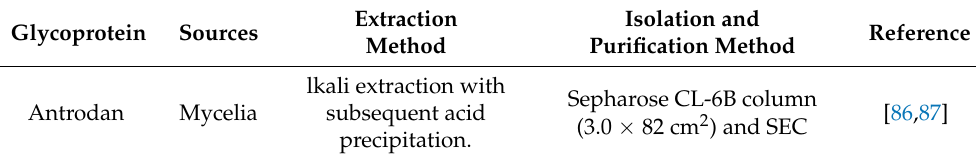
Table 6. Preparation procedures of glycoprotein from A. cinnamomea in recent publications.